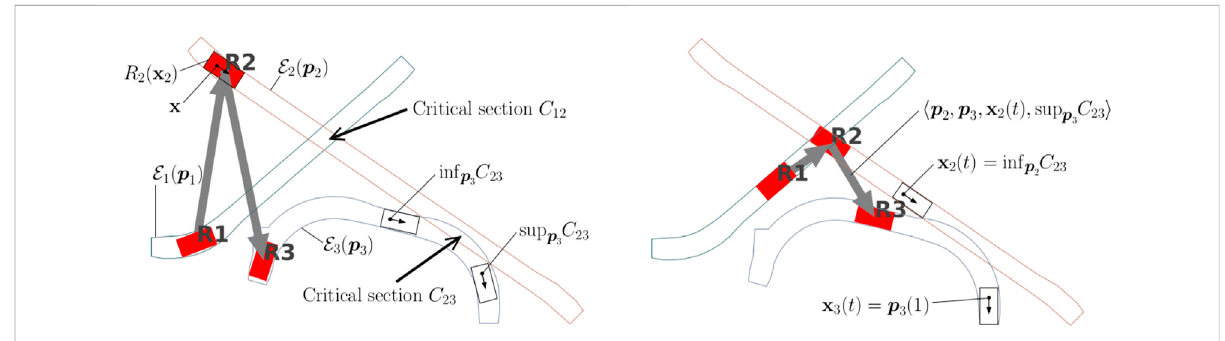
FIGURE 3 Threerobotsnavigatingalongpathsp 1 ,p 2 ,andp 3 .Spatialenvelopesandcriticalsectionsareshownontheleft;grayarrowsindicateprecedence constraints; detail of the precedence constraint regulating robots 2 and 3 as they navigate through C 23 is shown on the